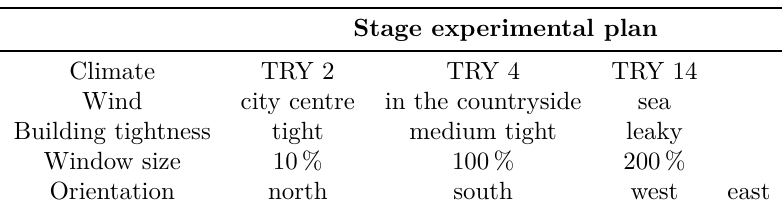
Table 1. Experimental